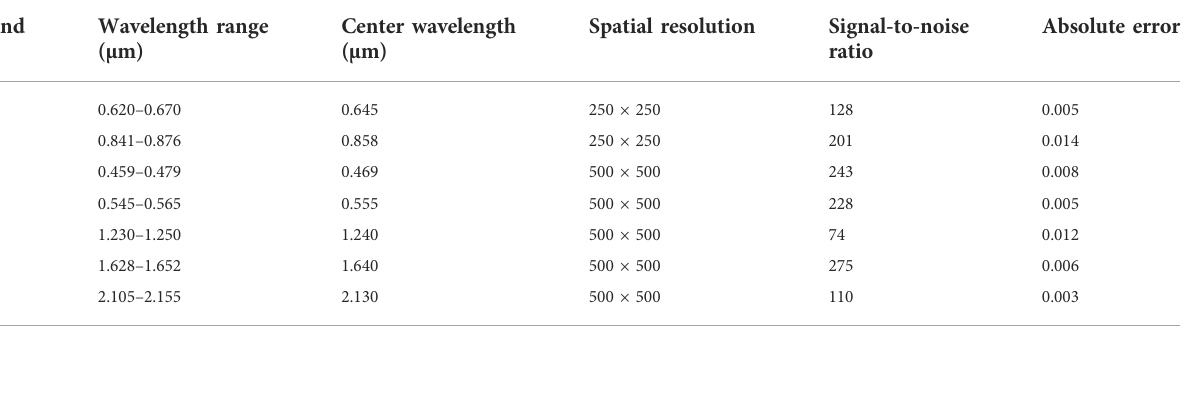
TABLE 1 MOD09 band parameters and theoretical accuracy.